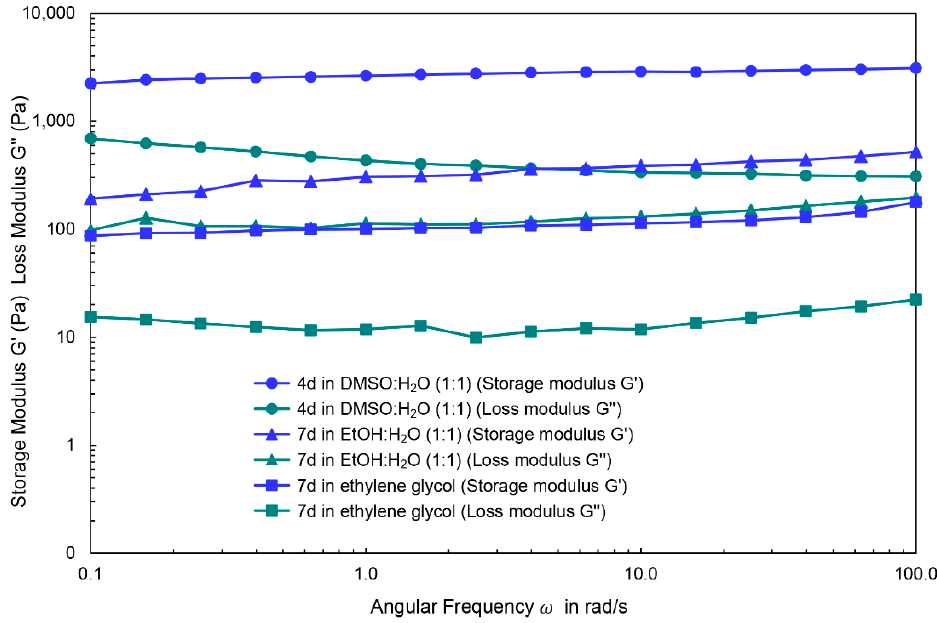
Figure 3. The rheological data for the gels formed by compound 4d in DMSO:H 2 O (1:1) at 10.0 mg/mL, 7d in EtOH:H 2 O (1:1) at 3.3 mg/mL and 7d in Ethylene glycol at 10.0 mg/mL. The strain was 1% for all samples.